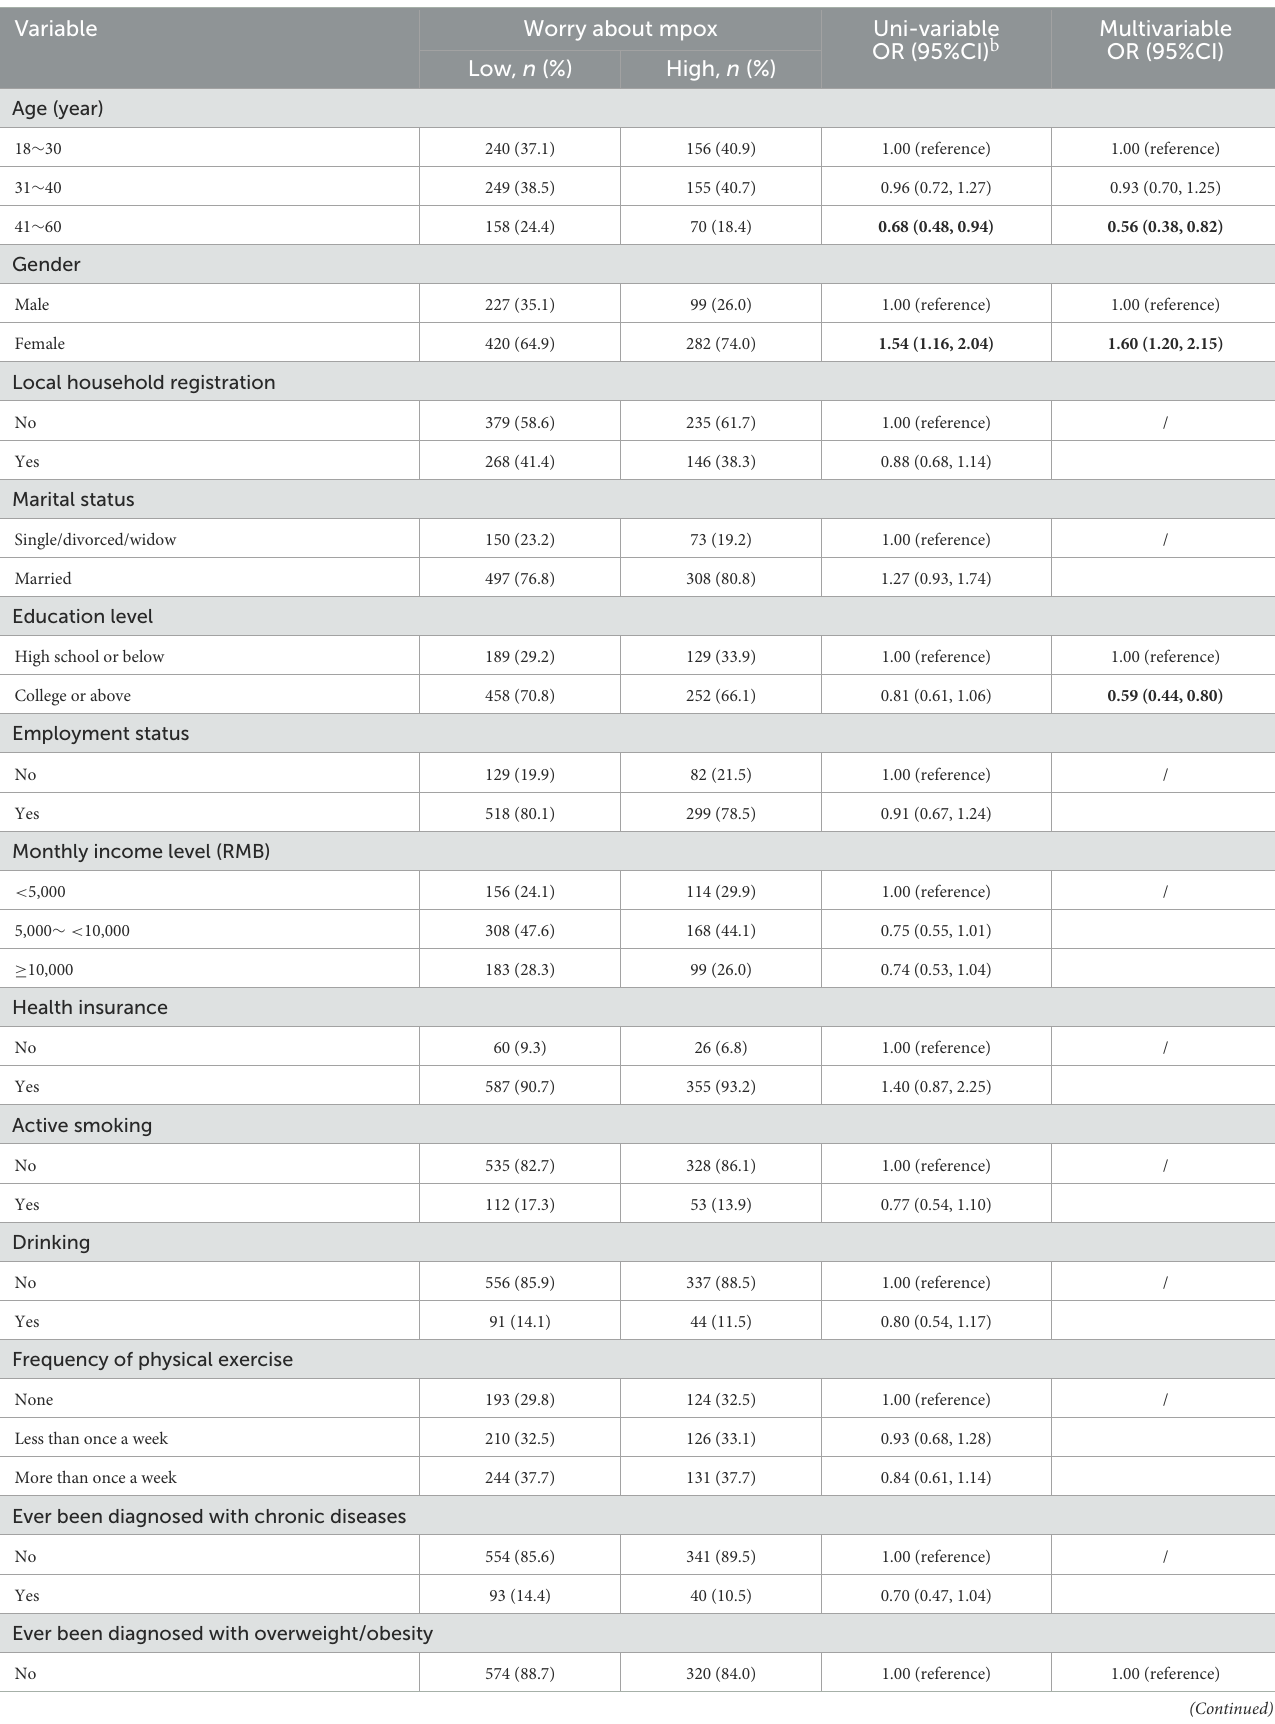
TABLE 4 Factors associated with worry about mpox in community residents ( N =